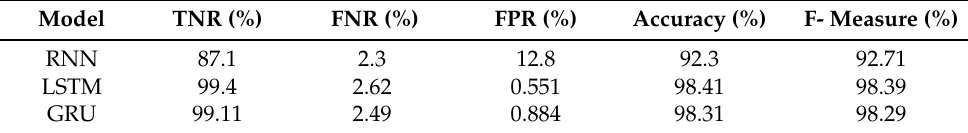
Table 10. Evaluation performance of RNN, LSTM, and